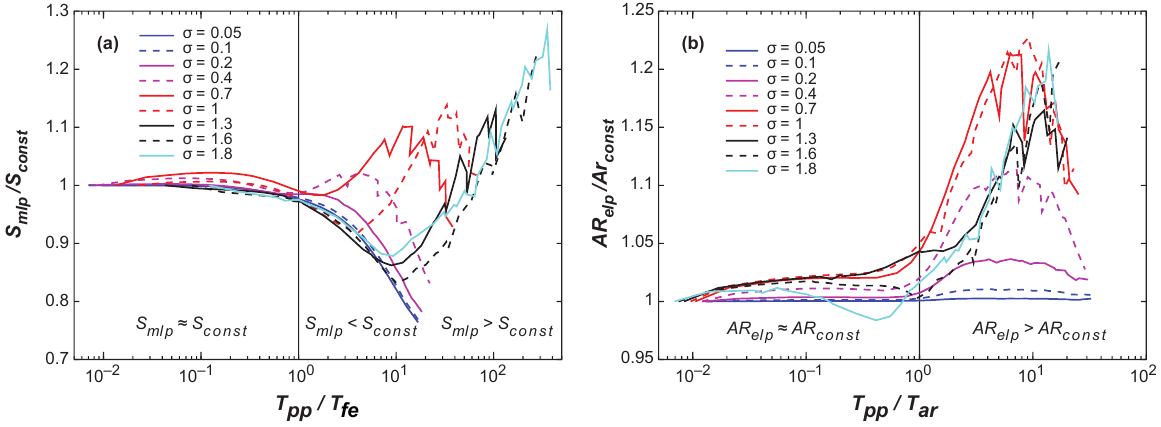
Figure 7. (a) Mean slope ratios in non-dimensional timescale. T pp /T fe < 1: model runs with a high-frequency sediment supply show similar equilibrium slopes and armouring ratios as conditions of constant sediment feed ( S mlp ≈ S const ). T pp /T fe > 1: if the GSD is narrow ( σ < 0 . 4) or the pulse period is not much longer than the fluvial evacuation time, we observe lower equilibrium slopes than in constant-feed runs ( S mlp < S const ). Runs with either very low frequency of supply events or wide GSD ( σ ≥ 0 . 4) show equilibrium slopes that are higher than the respective constant-feed runs ( S mlp > S const ). (b) Relative armouring ratio in non-dimensional timescale. T pp /T ar > 1: low frequency of supply events leads to an increase in armouring ratio compared to constant-feed runs (AR elp > AR const ), especially for wide GSDs ( σ ≥ 0 . 4).